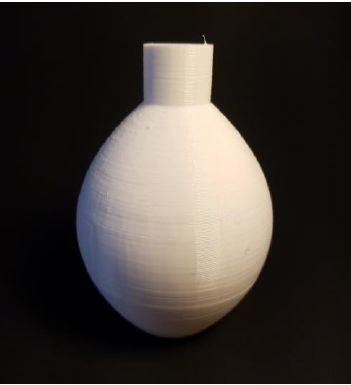
Figure 5. Example of medical device component: newborn medical ventilator bag.